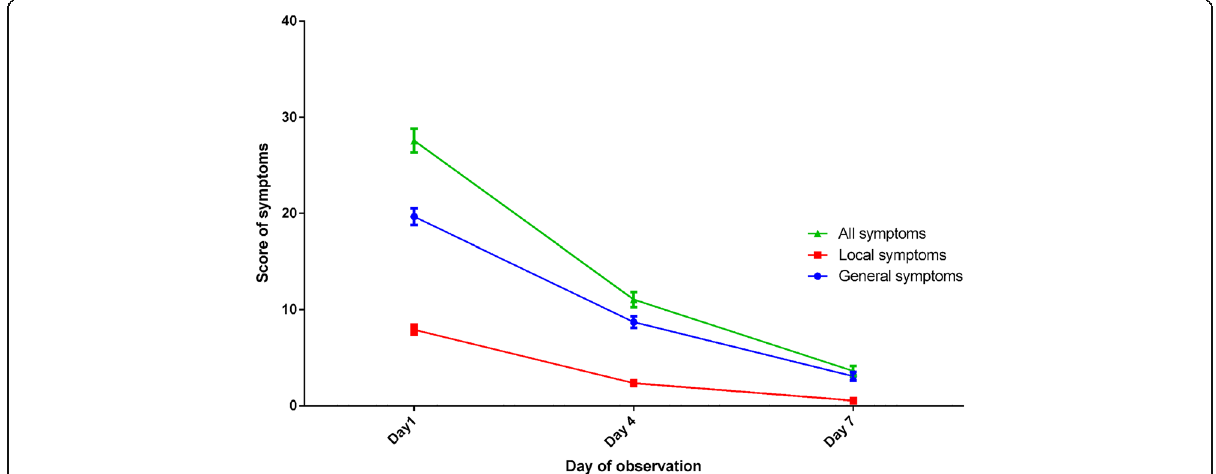
Fig. 1 Mean symptoms ’ scores and standard errors per day of